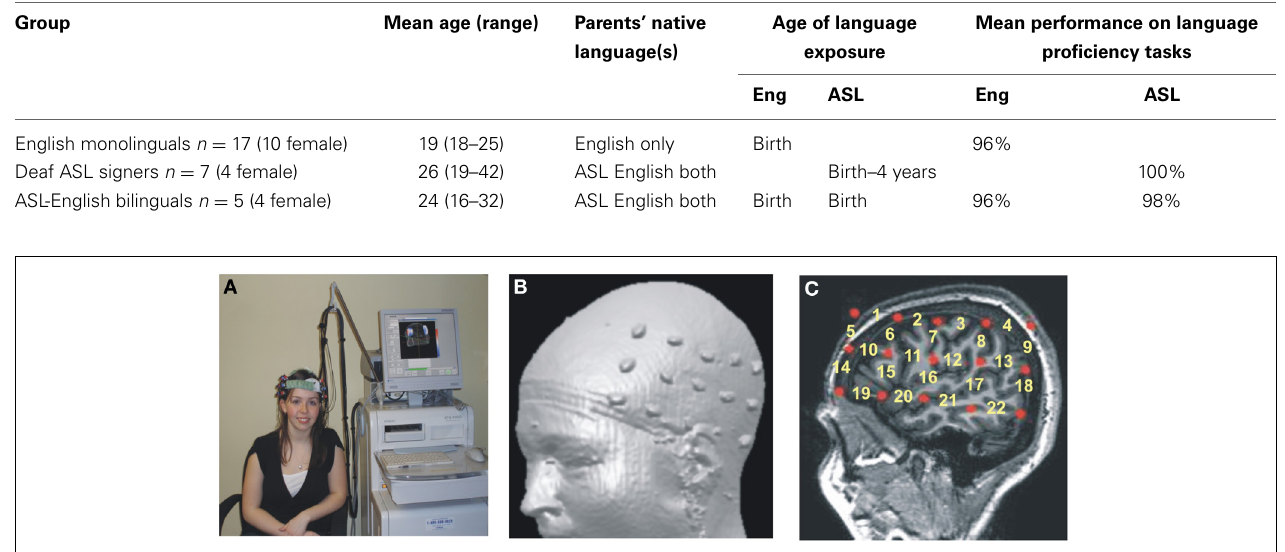
FIGURE 1 | Hitachi ETG-4000 Imaging System MRI Neuroanatomical Co-Registration. (A) Participant with a Hitachi 48-channel ETG-4000. Optodes in place and ready for data acquisition. The 3 × 5 optode arrays were positioned on participants’ heads using rigorous anatomical localization measures including 10 × 20 system and MRI coregistration. (B)